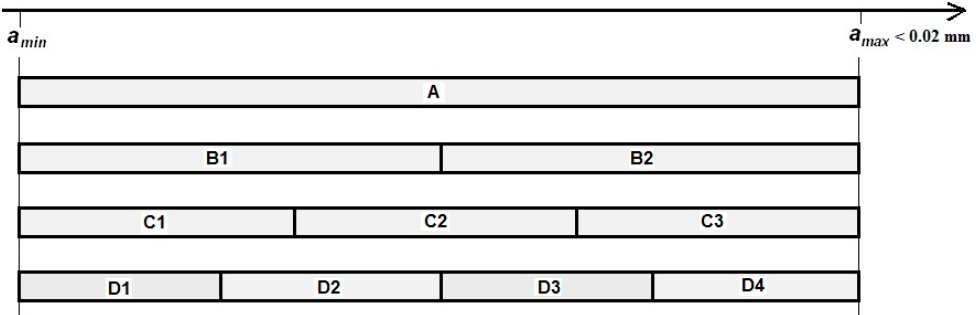
Figure 3. The method of division of soils into a different number of sets (A; B1–B2; C1–C3; D1–D4) during preliminary research.